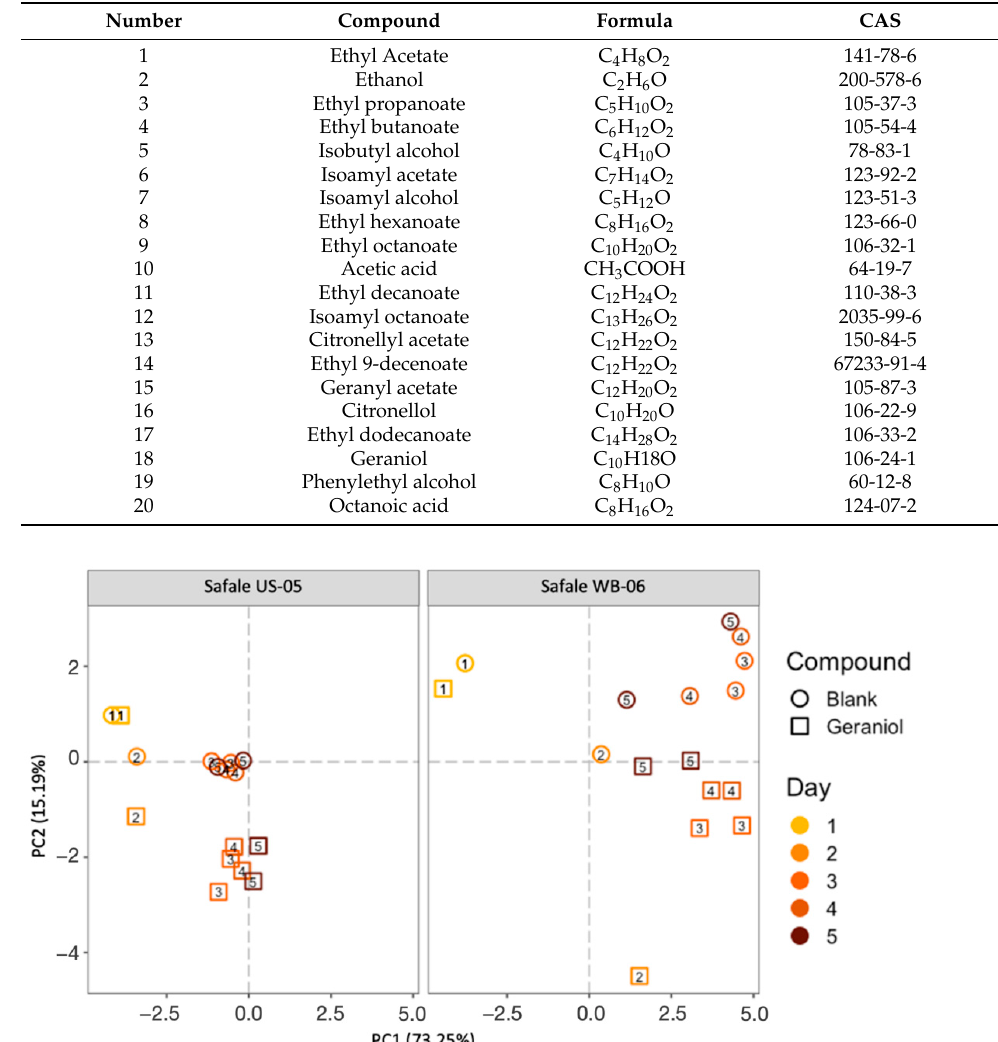
Figure 2. Score plot of the first two principal component analyses (PCA) of VOC produced during fermentation (5 days) by commercially available yeast: S. cerevisiae strain SafAle US-05 and S. cerevisiae var Diastaticus strain SafAle WB-06 (n = 2). Different colours represent the different days of fermentation.